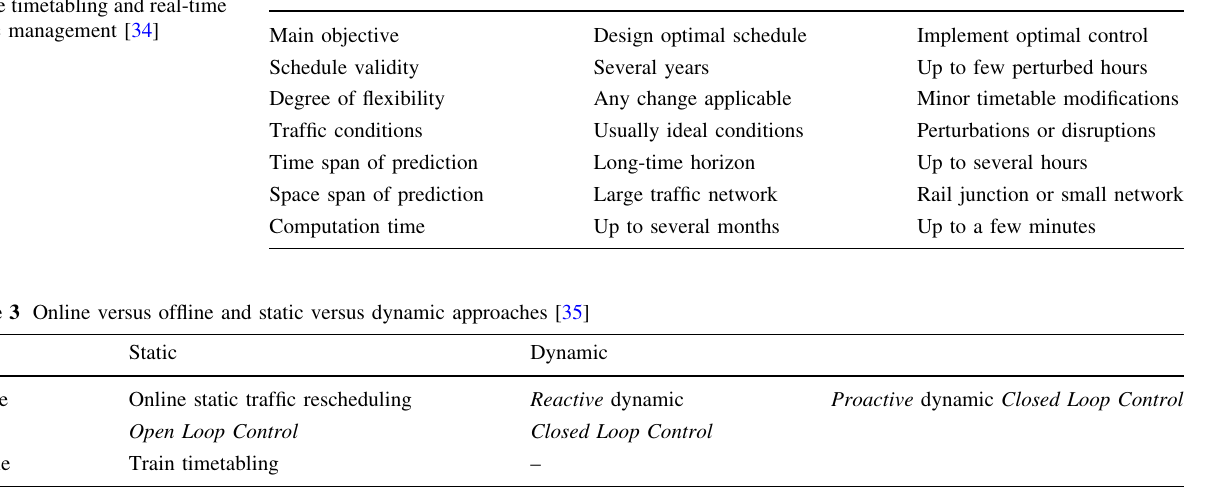
Table 2 Differences between